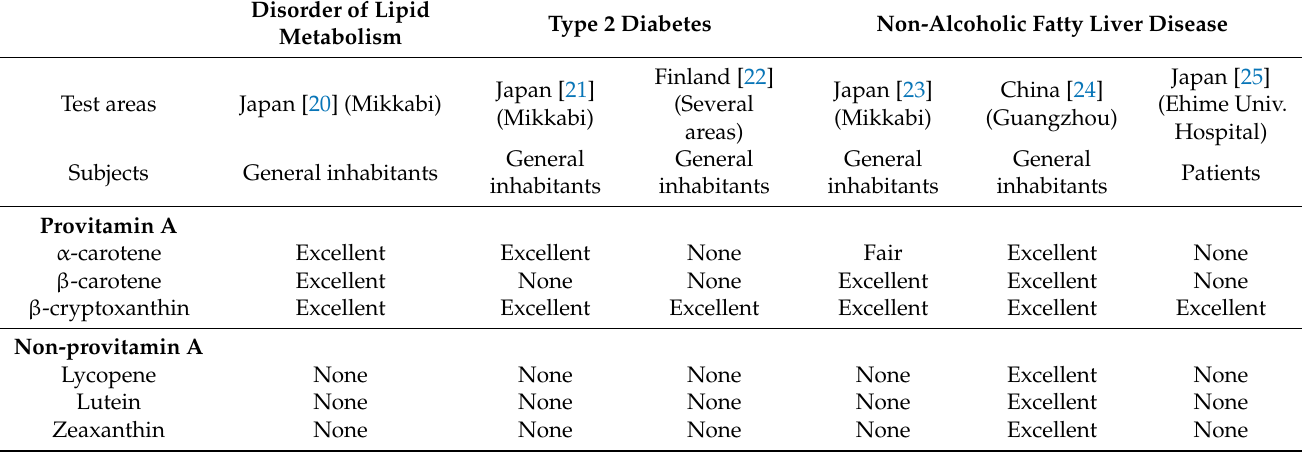
Table 1. Assessment of relationships between the carotenoid contents in blood or carotenoid con- sumption and risk of lifestyle-related diseases from several cohort